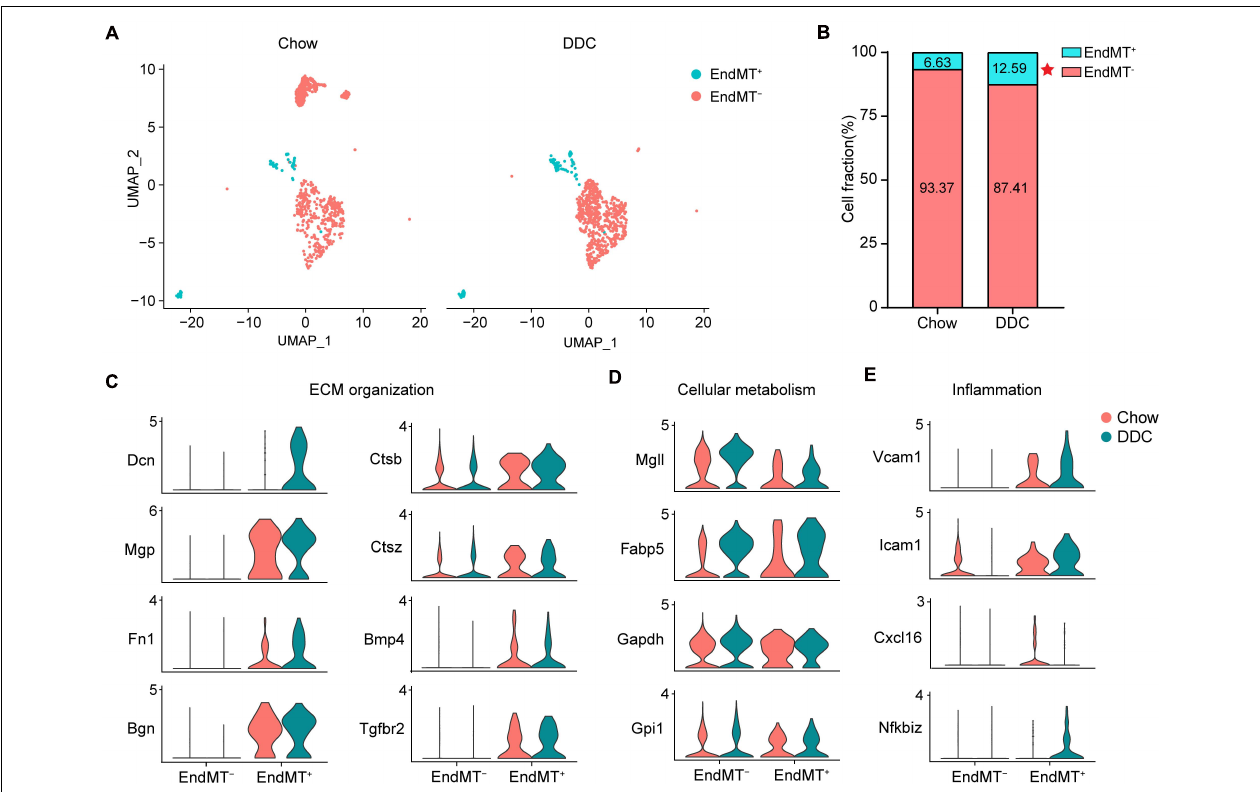
FIGURE 6 | Activated endothelial cells show distinct transcriptional features. (A) , UMAP plot of EndMT − and EndMT + cells across the two experimental groups. (B) , The percentage of EndMT − and EndMT + cells across the two experimental groups. * P < 0.05 using Chi-square test. (C – E) , Violin plot showing the genes associated with ECM organization (C) , cellular metabolism (D) , and inflammation (E) in EndMT − and EndMT + cells across the two experimental